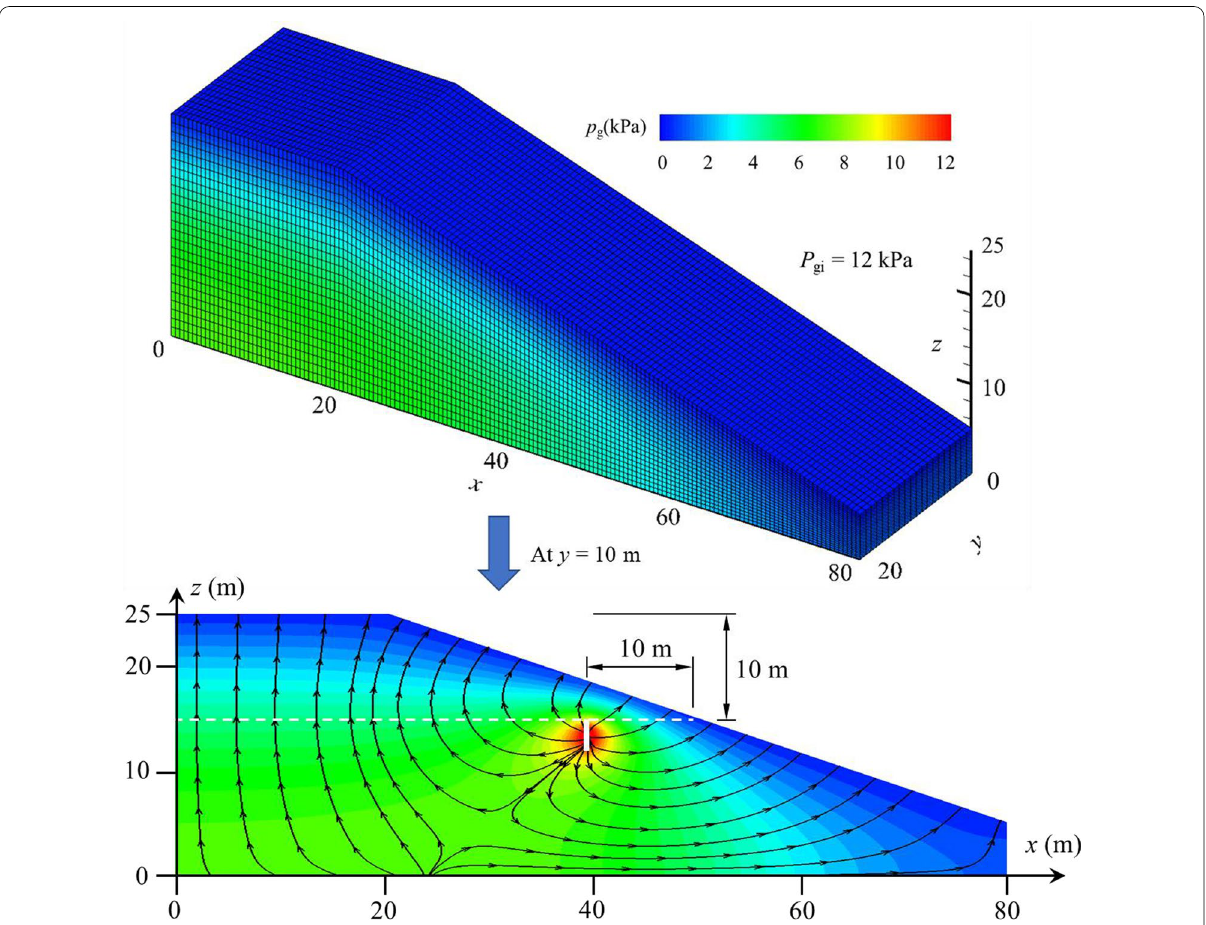
Fig. 8 The spatial distribution of gas pressure on the 20th day of